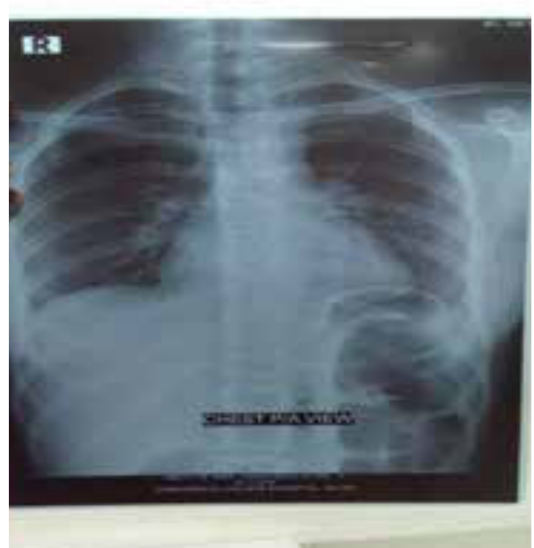
Fig 4. Chest X-ray showing bilateral pneumonitis